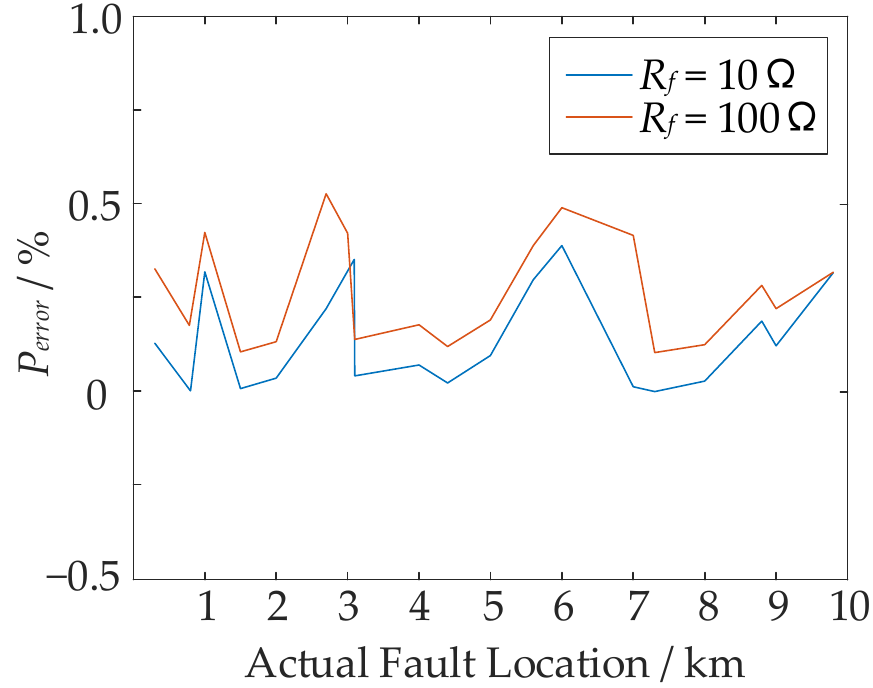
Figure 10. Fault location results and errors with fault resistors.